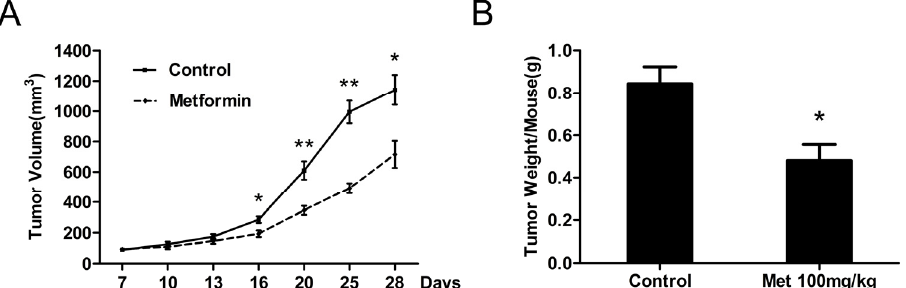
Figure 5. In vivo antitumor effects of metformin on bladder cancer xenograft model. Xenografts were generated by implantation of 2 × 10 6 cells of 5637 cells subcutaneously into the right flanks of nude mice. When the tumors reached a mean diameter of 6 mm, the animals were randomized into control and treated groups (five mice per group).